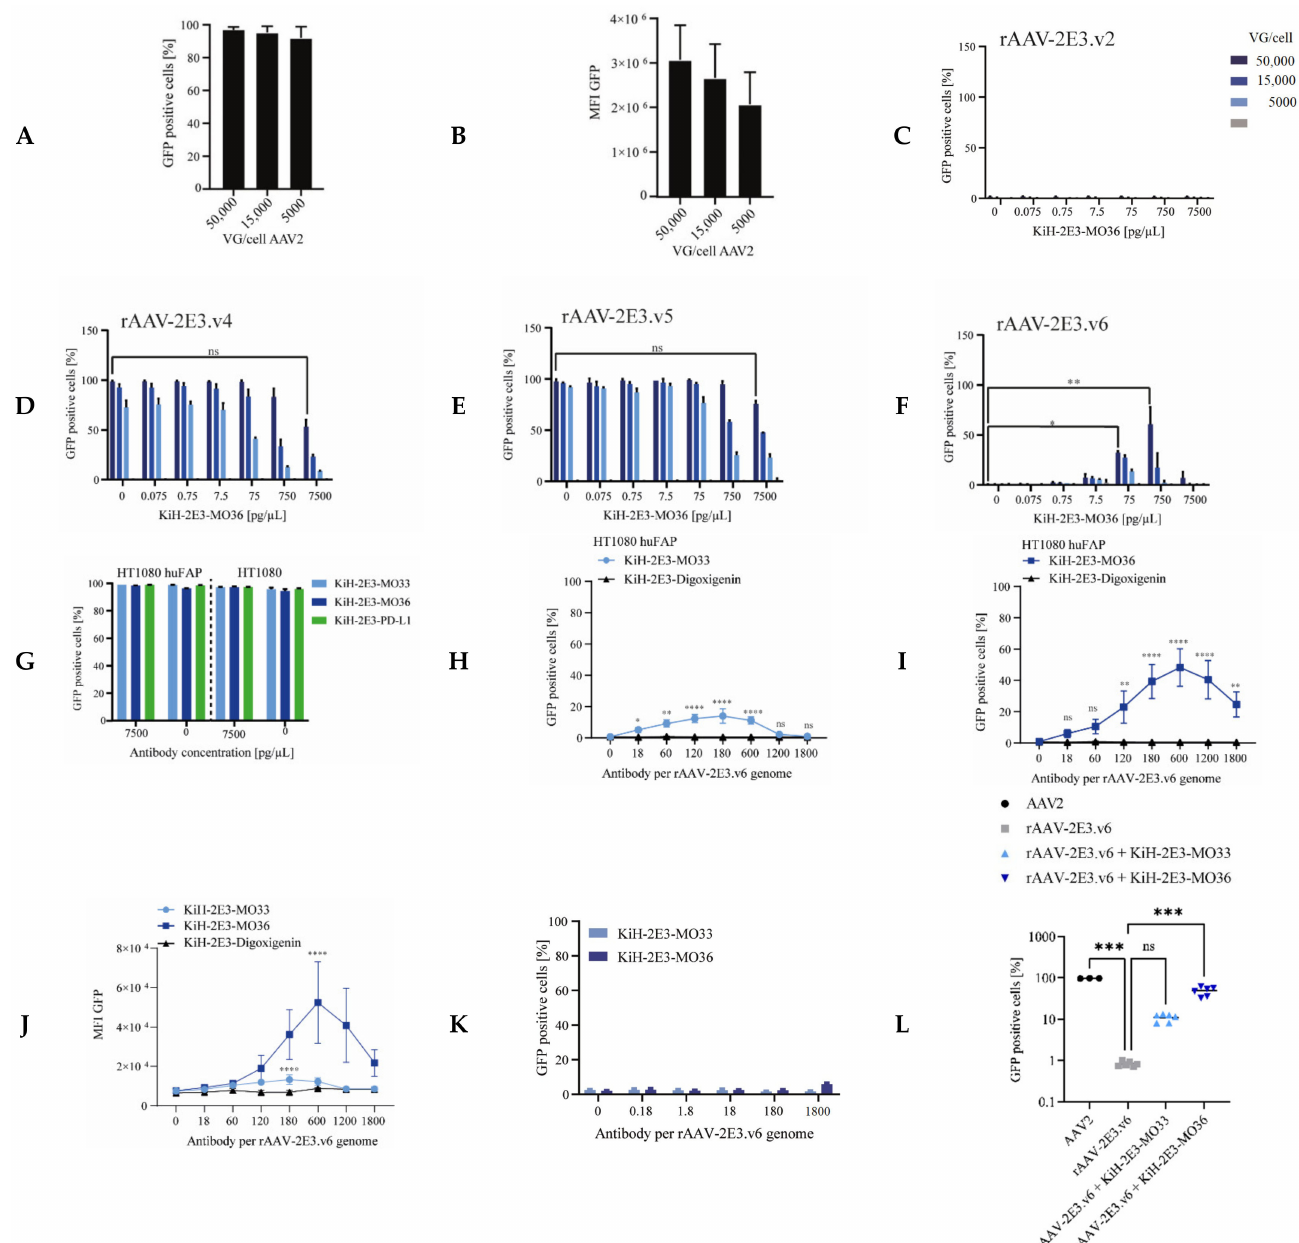
Figure 5. Retargeting novel rAAV-2E3 to FAP expressing cells using KiH bispecific antibodies. HT1080 huFAP cells were treated with AAV viral variants for 3 days following flow cytometry analysis. ( A ) AAV2 transduction with titrated VG/cell and analysis of GFP positive proportion and ( B ) MFI levels. Data show mean + SD. ( C ) Proportion of cellular GFP expression after retargeting with rAAV-2E3.v2, ( D ) rAAV-2E3.v4, ( E ) rAAV-2E3.v5, and ( F ) rAAV-2E3.v6 complexed with KiH-2E3-MO36. ( D – F ) share legend shown in ( C ). Data show mean + SD of two independent experiments, one-way ANOVA, uncorrected Dunn’s test, * p < 0.05; ** p < 0.01, ns= non-significant. ( G ) Bispecific antibodies pre-incubated with AAV capsids did not affect GFP expression levels of transduced cells. Data show mean + SD. ( H ) Titration of KiH-2E3-MO33, ( I ) KiH-2E3-MO36, and isotype control rAAV-2E3.v6 (VG/cell 50,000) and analysis of percentage of GFP expressing cells and ( J ) MFI levels. Data show mean + SD of three independent experiments, one-way ANOVA, uncorrected Dunn’s test groups compared 0.0 pg/ µ L KiH-2E3, * p < 0.05; ** p < 0.01; **** p < 0.0001, ns = non-significant. ( K ) rAAV-2E3.v6 complexed with KiH-2E3-MO33 or KiH-2E3-MO36 and incubation on HT1080 huFAP negative cells did not result in GFP expression. Data show mean + SD. ( L ) Direct comparison of HT1080 huFAP GFP expression levels after transduction with AAV2, rAAV-2E3.v6, rAAV-2E3.v6:KiH-2E3-MO33, and rAAV-2E3.v6:KiH-2E3-MO36 at 50,000 VG/cell and 2.5 ng/ µ L bispecific antibody, one-way ANOVA, uncorrected Dunn’s test *** p < 0.001, ns =